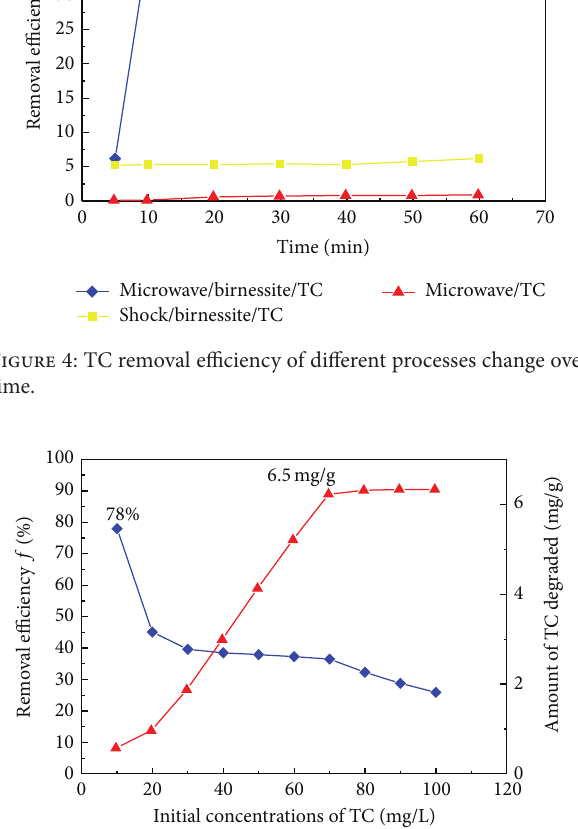
Figure 5: Changes in removal efficiency and the amount of degradation with different initial concentrations of TC solution.